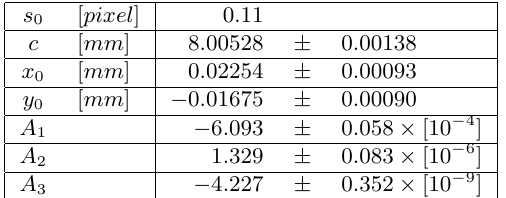
Table 1: Parameters of the exterior orientation